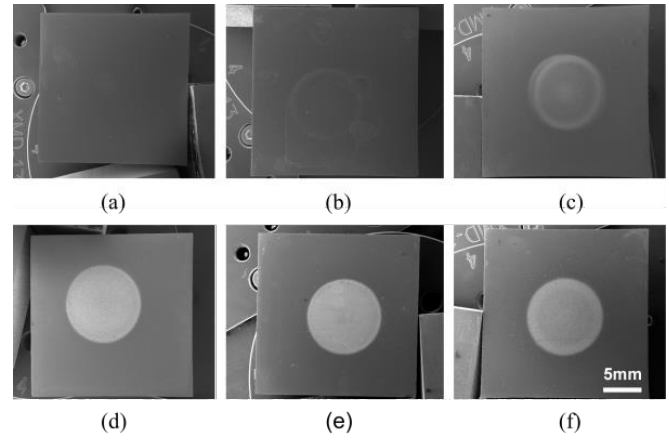
Figure 2. Eroded surfaces of specimens of 420 after different cavitation times: ( a ) 10 min, ( b ) 30 min, ( c ) 60 min, ( d ) 120 min, ( e ) 180 min, and ( f ) 240 min.